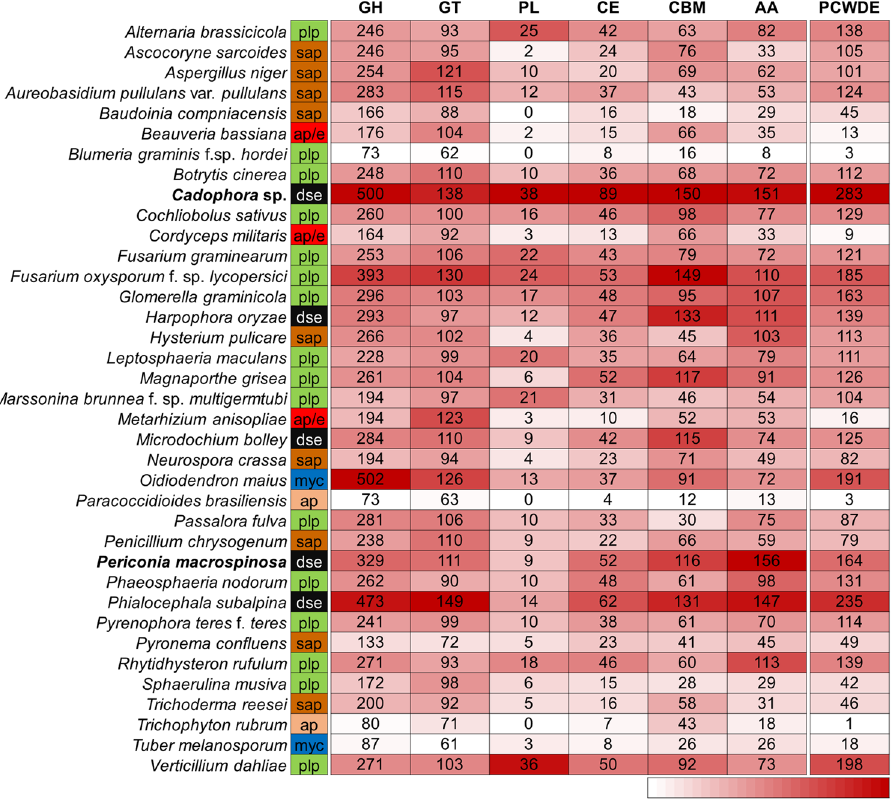
found within our two DSE genomes, with the enlarged families being GH3 (b-glucosidase/b-xylosidase), GH16 (b-galactosidase/b-glucanase), GH18 (chitinases) and GH43 (a-arabinofuranosidase/b-xylosidase). We also found high gene numbers of GH78 (a-rhamnosidase) family, but only in Cadophora sp. In general, the DSEs possessed relatively high number of genes in the CAZyme superfamilies and families/subfamilies across the Ascomycota taxa examined. This was the case, for example, for CBM1, CBM18 and CBM50 among the CBMs, and AA3_2 and AA9 among the AAs (Supplementary Table S4). We also found Cadophora sp. and P. macrospinosa to be enriched (p value < 0.001, Fisher’s exact test, Supplementary Table S3) in proteins with PCWDE domains (283 and 164, respectively), and a PCA based on PCWDEs separated our DSEs from other species (Fig. 5b). Cadophora sp. has the highest number of PCWDE genes out of all ascomycetes analyzed in this study (Supplementary Table S5). This species has even more PCWDEs than the pathogenic Colletotrichum species ( > 240) 83,86,87 , and the other helotialean DSE, P. subal- pina (235) (Supplementary Table S5). Even though the most abundant PCWDE domains were the same (GH43, CBM1, and AA9) for both DSEs, the two species were separated from each other in the PCA (Fig. 5b). In this analysis the five DSE did not form a separate group as when the whole CAZomes were analyzed. The fact that these DSEs possess a high number of CAZymes and PCWDE domains suggests that they have a particular and broad spectrum of degrading enzymes and possible plant cell wall degrading capacity. Several genomic studies showed that an expanded CAZyme and PCWDE repertoire was linked with saprobic and/or plant pathogenic abilities of fungi 30,38,88–90 . This is consistent with the fact that those fungi are able to break down complex plant polysaccharides - a feature that is important for establishing infection and accessing nutrients during necrotrophic and saprotrophic growth. The PCA of PCWDEs revealed a loose association between DSE fungi, root colonizing plant pathogens ( Fusarium oxysporum and Verticillium dahliae ) and the ericoid mycor- rhizal fungus, O. maius , along the first axis (Fig. 5b). However, these species dispersed along the second axis, indicating that they have substantial differences with respect to PCWDE domains. Schlegel et al . 29 found a similar